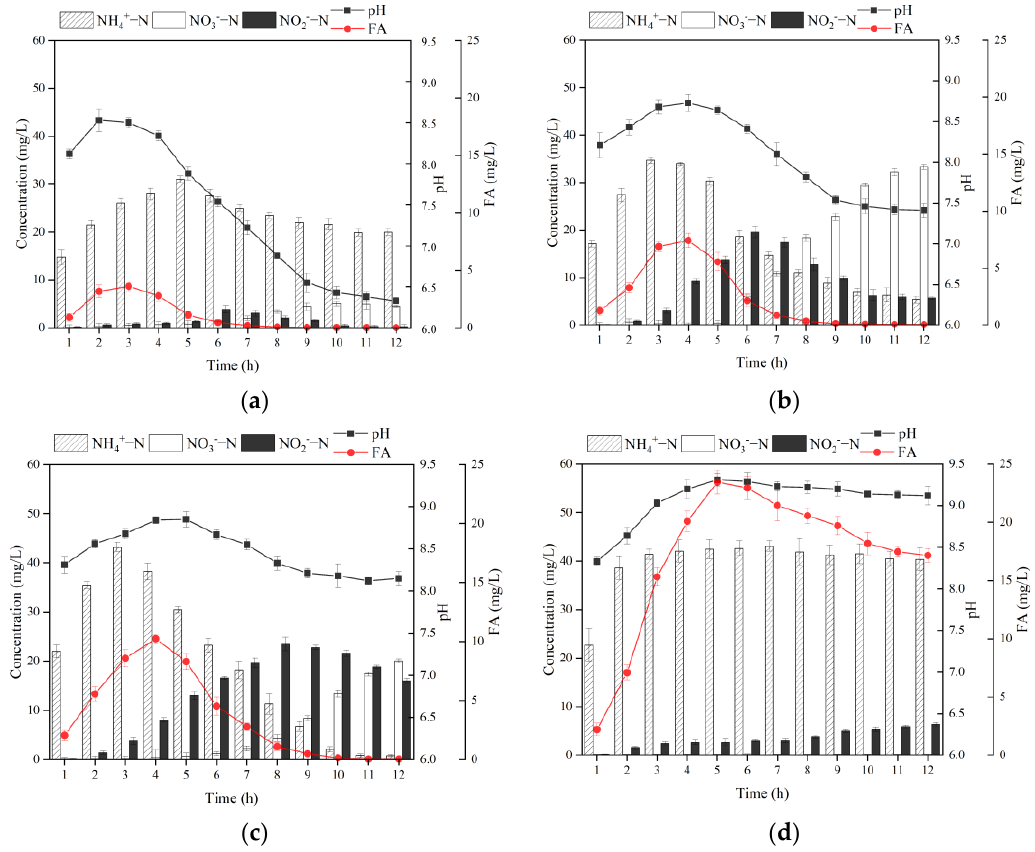
Figure 5. Changing patterns of different forms of nitrogen, pH, and FA under different alkalinity ratios in MBBR. ( a ) 0.5 times; ( b ) 1 time; ( c ) 2 times; ( d ) 4 times. Vertical bars represent ± SD of the means ( n = 3).